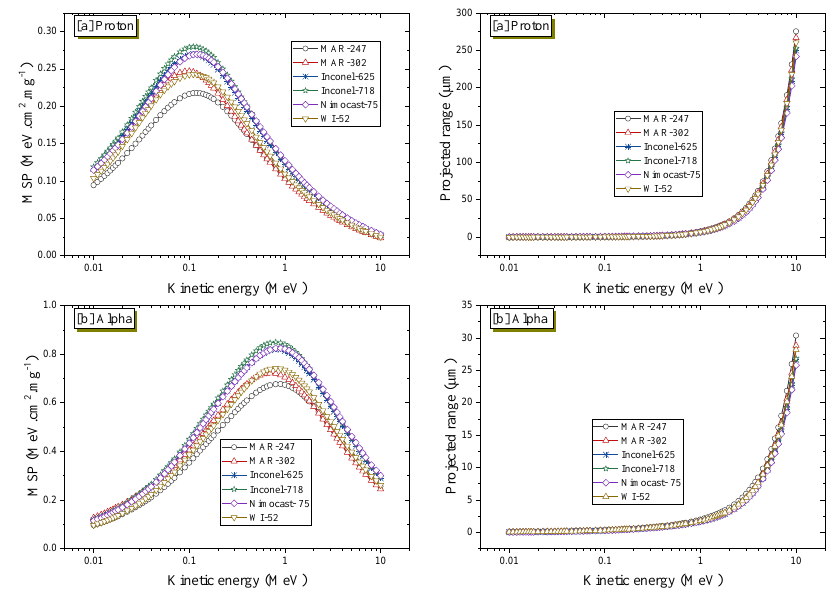
Figure 10. Variation of the mass stopping power (MSP) and the projected range versus the kinetic energy.for the projected particles: ( a ) Protons, ( b ) Alpha particles